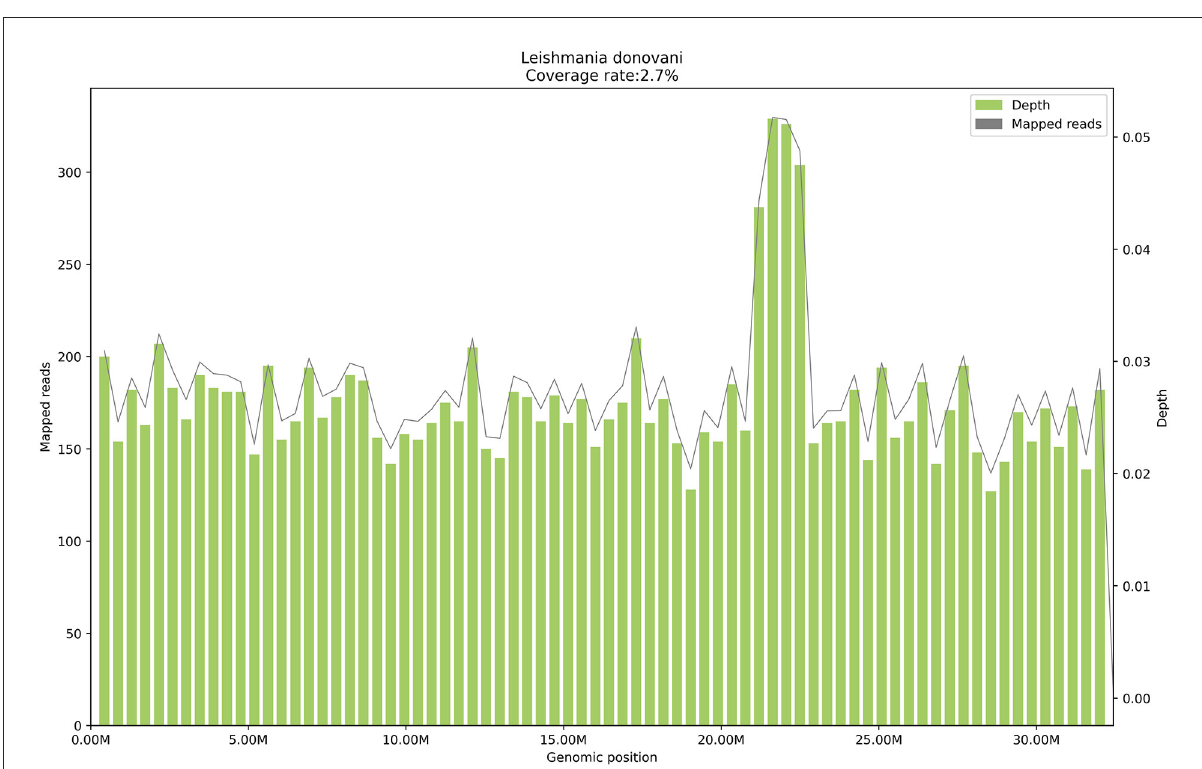
FIGURE1 The genome coverage map of Leishmania donovani detected by mNGS in case 1. The genome coverage of Leishmania donovani in the peripheral blood of case 1 is